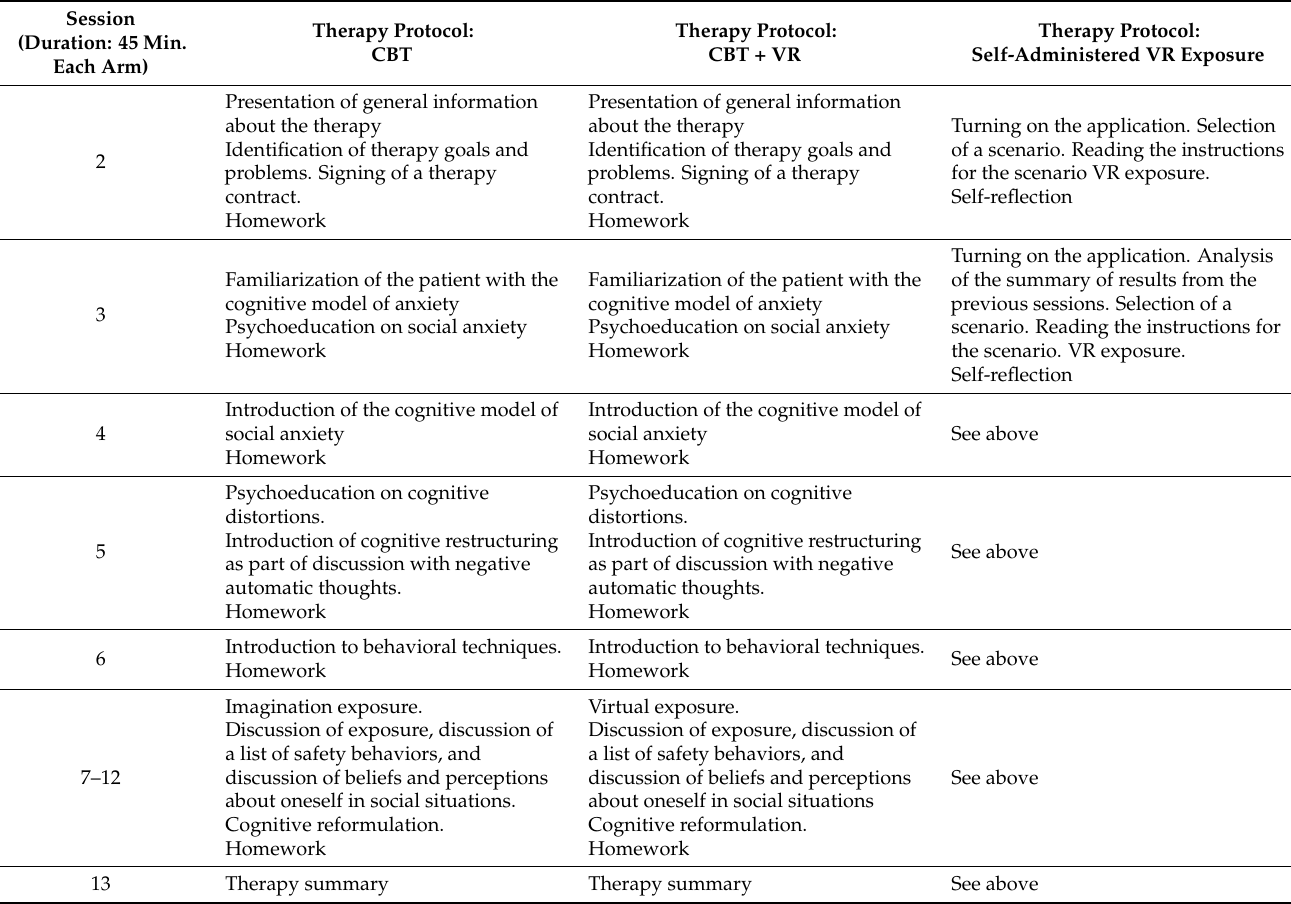
Table 3. Short protocols for CBT, CBT + VR, and self-administered VR